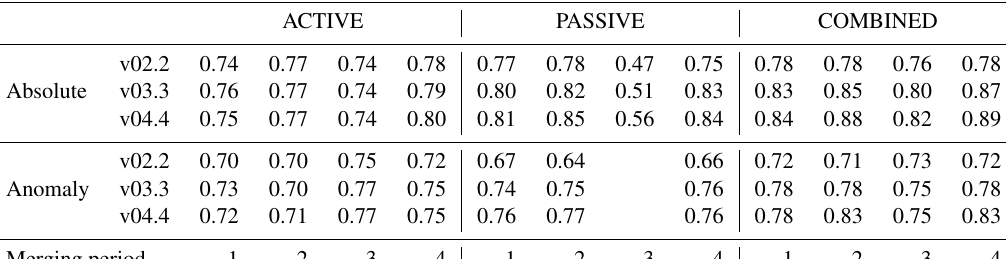
Table 4. Median correlations against the unknown truth of absolute soil moisture time series and soil moisture anomalies from the ACTIVE, PASSIVE and COMBINED ESA CCI SM product versions v02.2, v03.3 and v04.4 in the latest four merging periods. Merging periods 1, 2,